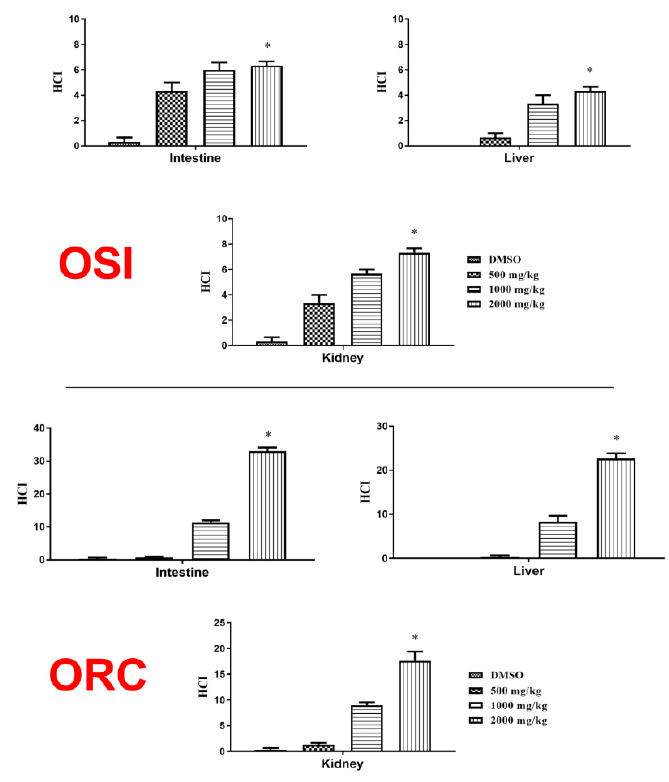
Figure 2. Effect of oral treatment with Ormona ® SI (OSI) and Ormona ® RC (ORC) (500 mg/kg, 1000 mg/kg and 2000 mg/kg) on histopathological change index in the intestine, liver, and kidney of adult zebrafish. The results are represented as a mean ± SEM. *: p < 0.05 vs. DMSO (Kruskal–Wallis followed by Dunn’s post hoc